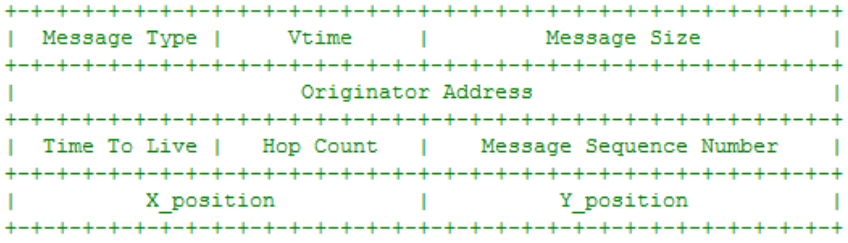
Figure 6. New OLSR message header format.